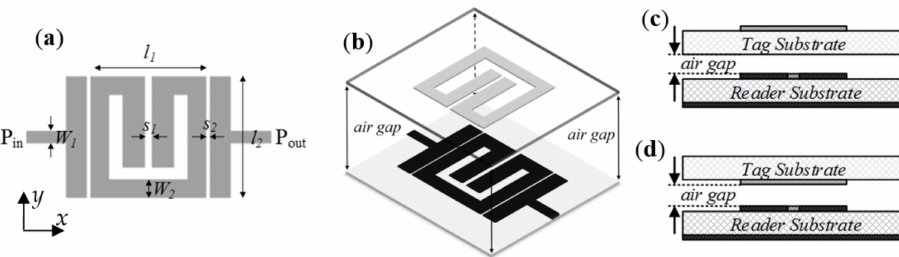
Figure 2. ( a ) Layout of the channel lines, consisting of a split-ring resonator (SRR)-loaded microstrip line with SRR coupled to the input and output ports through capacitive gaps (relevant dimensions are indicated); ( b ) perspective view of the channel line with tag on top of it; ( c ) cross section view of the channel line with tag on top of it and SRR tags etched on the top side of the substrate (further away from the reader); ( d ) section view of the channel line with tag on top of it and SRR tags etched on the bottom substrate side (closer to the